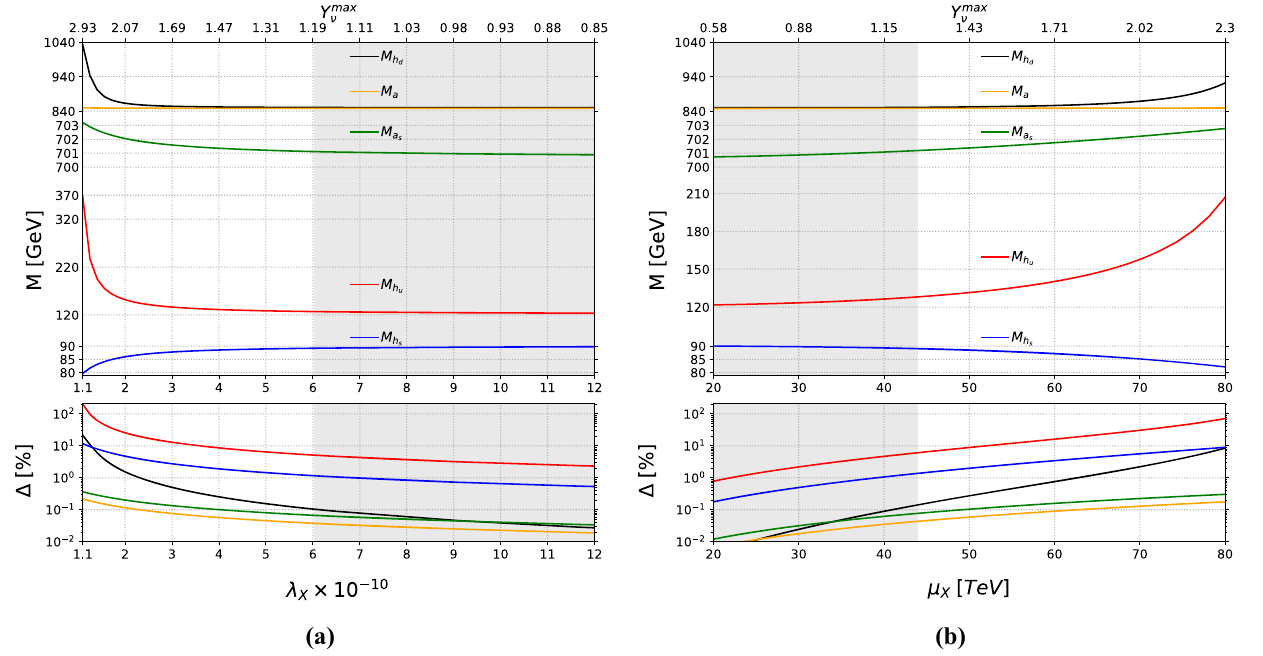
(a) (b) Fig. 4 Parameter point P1 : The loop-corrected Higgs boson masses in are denoted by their main components ( h u , h d , h s , a , a s ) correspond- (cid:2) (cid:3) α α + α 2 as function of the parameter λ X (upper GeV at order O ing to the five colors (red, black, blue, yellow, green). The gray area on t s t the plots denotes the points satisfying our constraints. Y max ν denotes the left) and of μ X (upper right) The relative corrections (cid:11) defined in (5.106) are shown in the lower panels. The five Higgs boson masses maximum element of the neutrino Yukawa matrix (cid:5) (cid:4) μ X is this study we retain parameter points where log μ